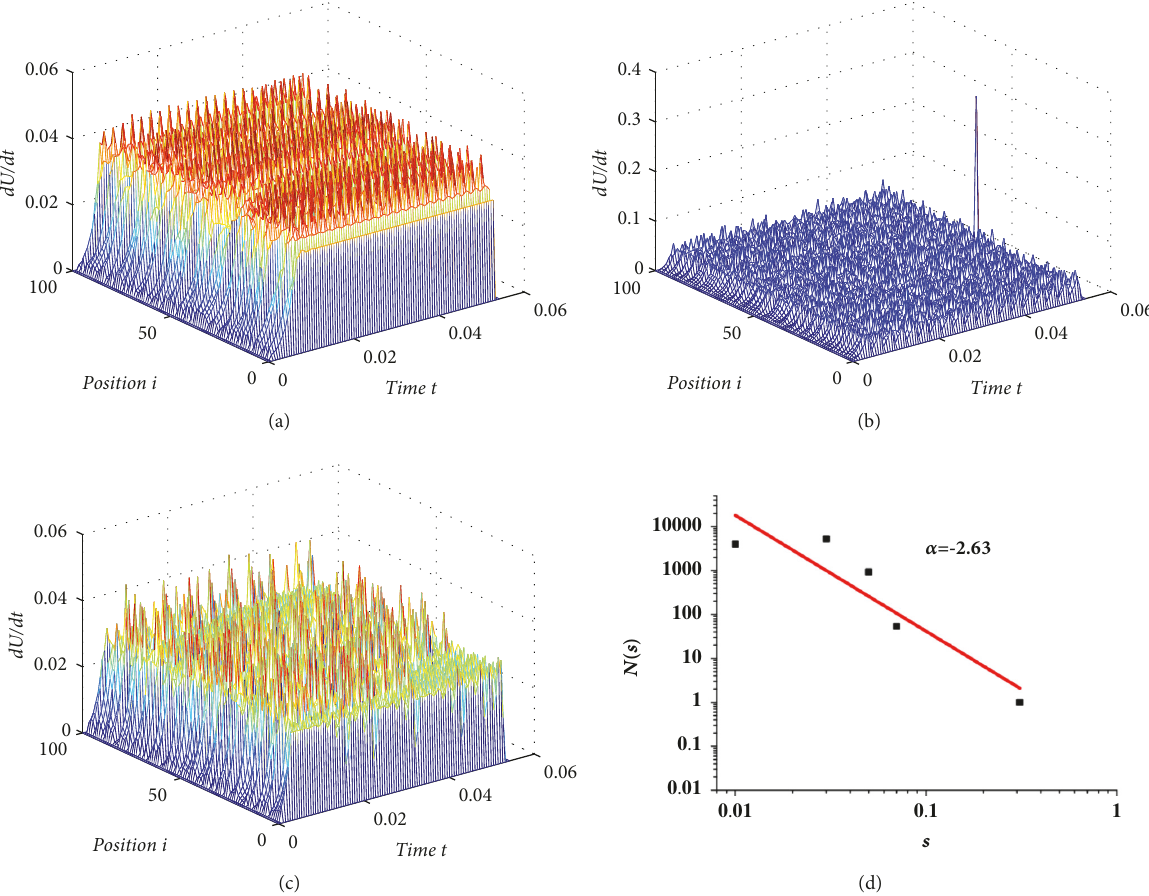
Figure 10: Numerical simulation at different temperatures 𝑇 and perturbation parameters 𝜀 . (a) 𝑇 = 293𝐾, 𝜀 = 0.025 ; (b) 𝑇 = 293𝐾, 𝜀 = 0.03001975 ; (c) 𝑇 = 173𝐾, 𝜀 = 0.03001975 ; (d) the distribution 𝑁 vs. the sliding speed, 𝑑𝑈/𝑑𝑡 , of each block at 𝑇 = 293𝐾, 𝜀 = 0.03001975 , where 𝑁() represents the number of blocks with sliding speed, 𝑑𝑈/𝑑𝑡 . V 0 = 0.00001,𝑐 = 340 , and the other parameters used here are listed in Table 1.